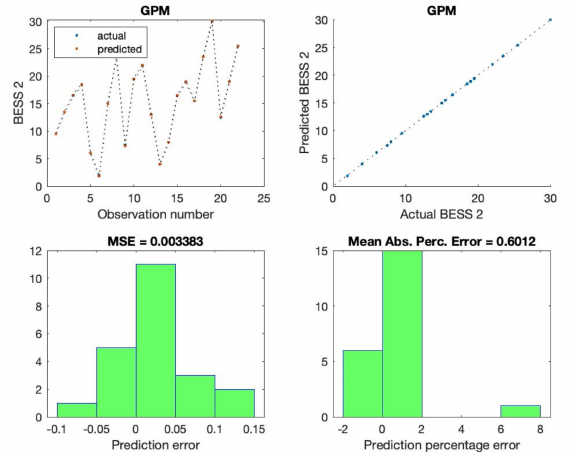
Figure 15. Machine learning results of the GPM mdl for BESS